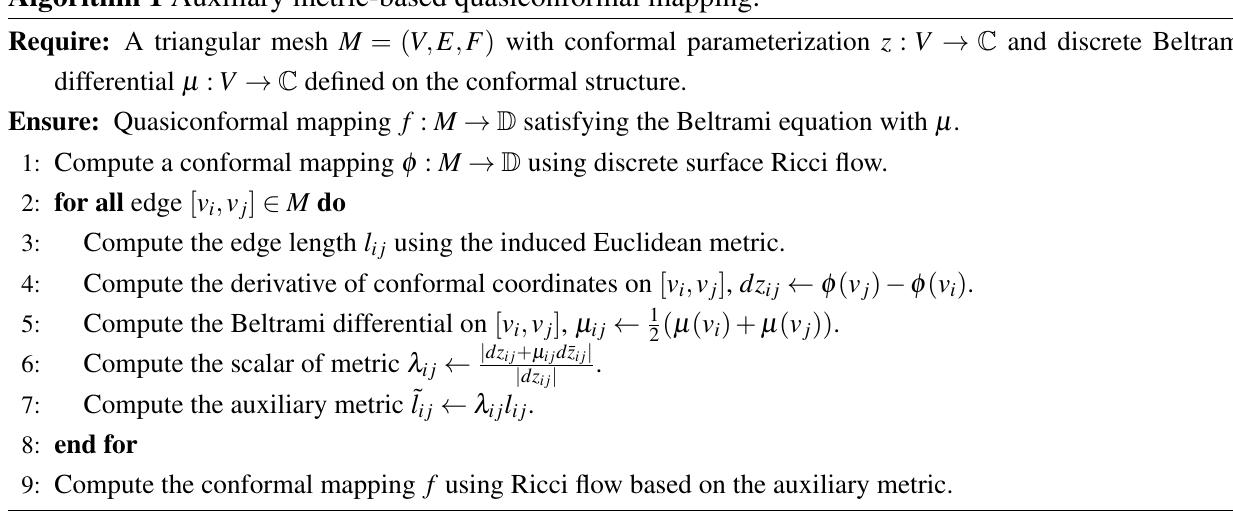
Algorithm 1 Auxiliary metric-based quasiconformal